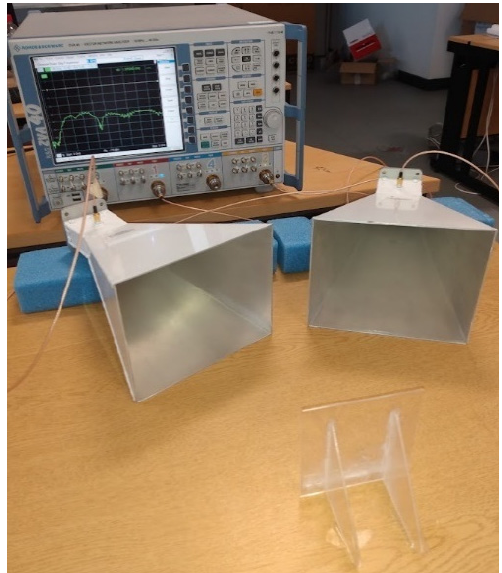
Figure 9. VNA and horn antennas used to interrogate the sample.